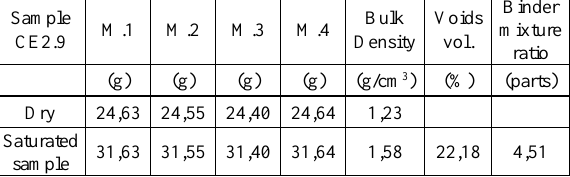
Table 3. CE2.9 sample Earth Voids Index for 20 cm3 volume. Produced by the authors. added to the mixture has been defined, multiplying the voids index found by the density of the earth-sand mixture (Zerbinatti,